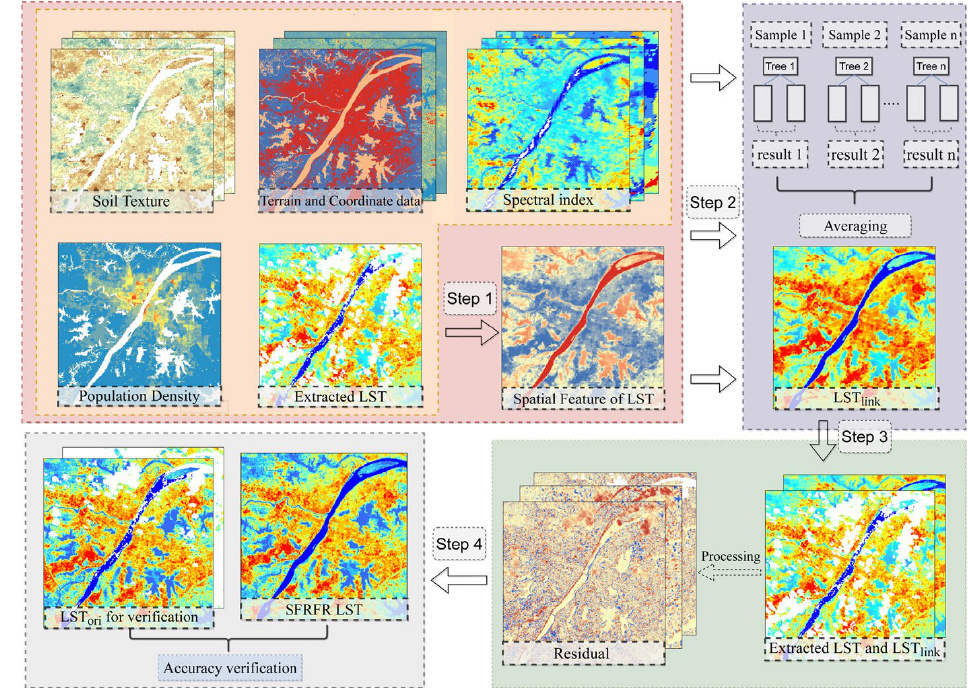
Figure 2. Flowchart of the proposed method for reconstructing missing data.